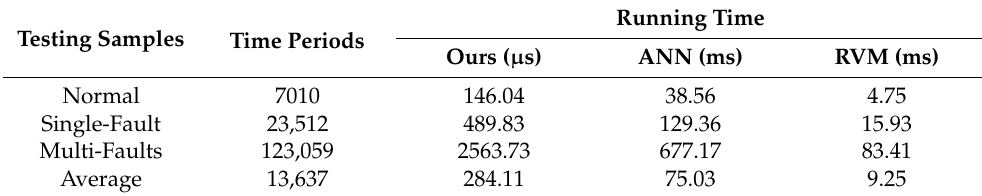
Table 12. Computation speed of Self-Detection and Self-Calibration on CC1350.